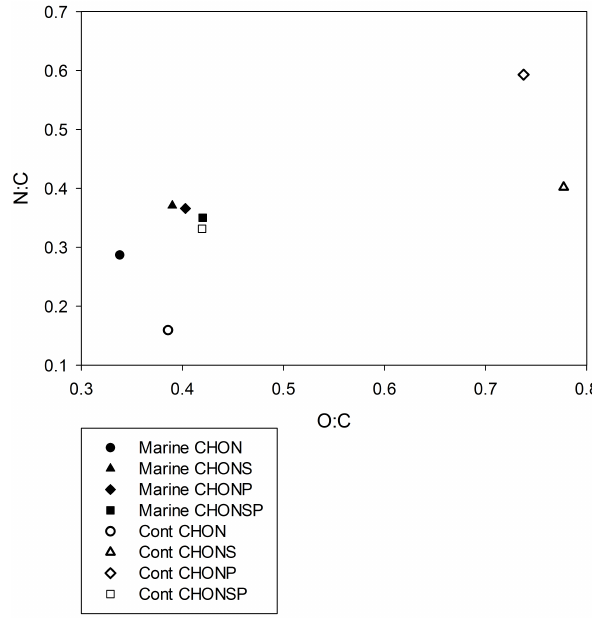
Fig. 3. van Krevelen diagram of the average elemental ratios of N containing compound classes in combined marine rainwater sam- ples and previously published continental rainwater (Altieri et al., 2009b).